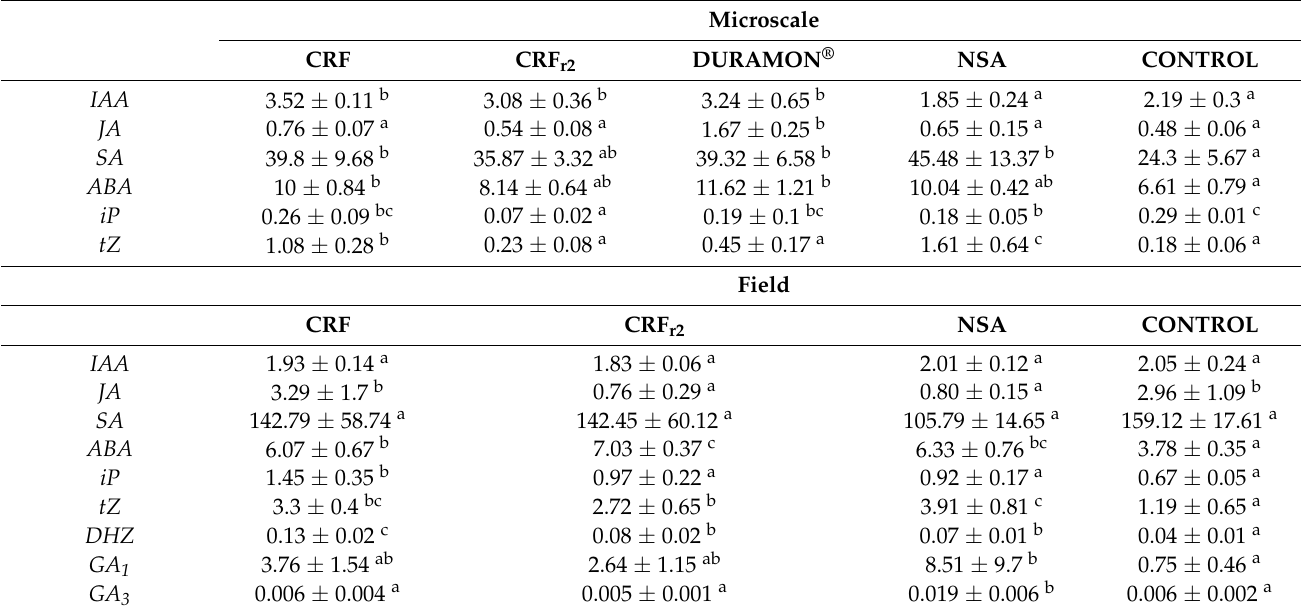
Table 2. Hormone activity comparison between fertilizer treatments applied (CRF, CRF r2 , NSA) compared to CONTROL. Hormones quantified were indoleacetic acid ( IAA ), jasmonic acid ( JA ), salicylic acid ( SA ), abscisic acid ( ABA ), and cytokinins —including isopentenyl adenine ( iP ), t-zeatin ( tZ ) and dihidrozeatin ( DHZ ). Also, at field level gibberellins ( GA 1 , GA 3 ) were quantified (Microscale- CRF, DURAMON ® and NSA: 350 kg ha − 1 ; CRF r2 : 280 kg ha − 1 . Field- CRF, NSA: 300 kg ha − 1 ; CRF r2 : 240 kg ha − 1 ). Values are means ± SD ( n leaf pools per treatment = 4) at the end of the culture and expressed in ng hormone g − 1 FW